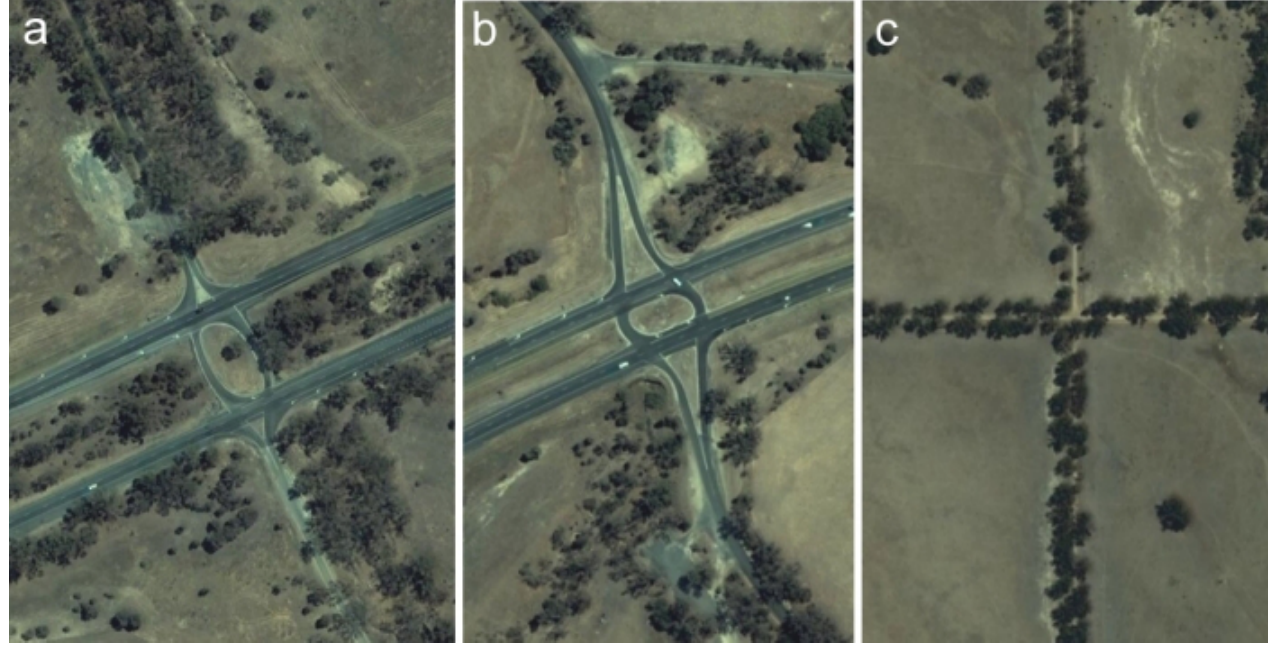
Fig. 3 . Aerial photograph of each site type showing the intersection between a) the Hume Freeway and a secondary road with trees present in the center median of the freeway (Trees), b) the Hume Freeway and a secondary road with no trees present in the center median of the freeway (No-Trees), c) two secondary roads away from the Hume Freeway (control). (Source: GoogleTM